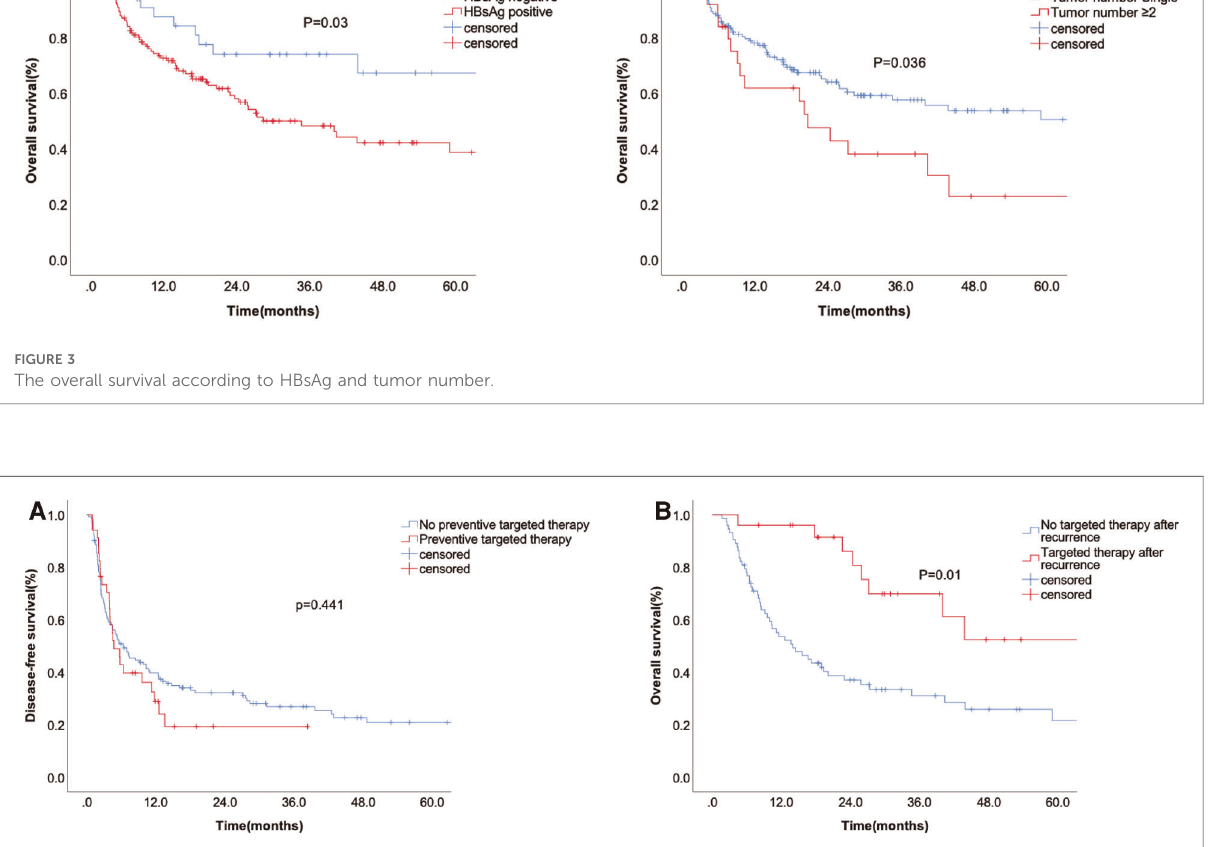
FIGURE 4 The disease-free survival according to preventive targeted therapy before liver resection ( A ) and overall survival ( B ) according to whether accepting targeted therapy after recurrence.